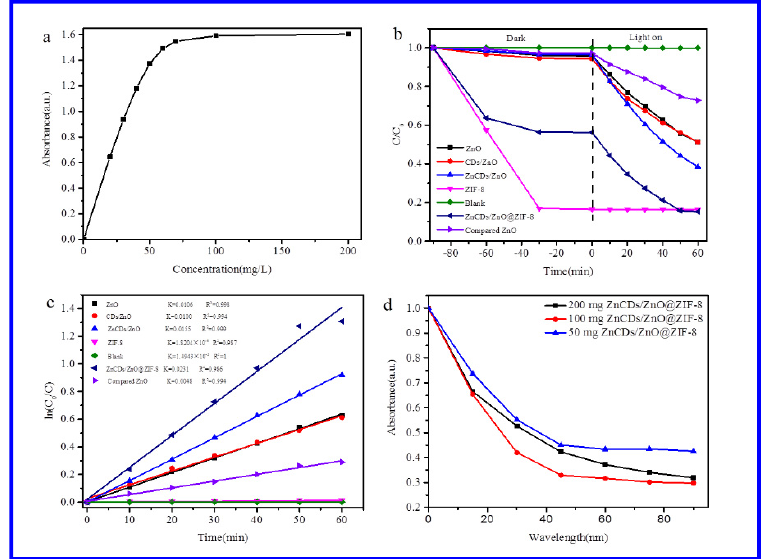
Figure 8. ( a ) Linear relationship between the concentration and Uv-vis adsorbance of TC. ( b ) The photocatalytic performance of verious materials for the degradation of TC. ( c ) Linear relationship of degradation kinetics over ZnCDs/ZnO@ZIF-8 and other related materials. ( d ) The photocatalytic activity with different qualities of ZnCDs/ZnO@ZIF-8.